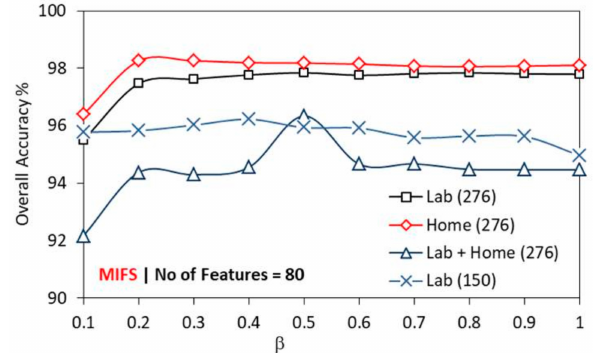
Figure 11. Performance of MIFS with β on di ff erent